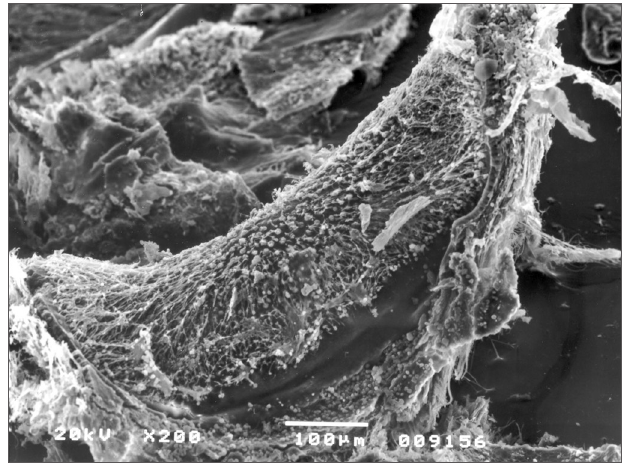
Figure 5. Saccular macula of the otosilicate group - 90 days, without